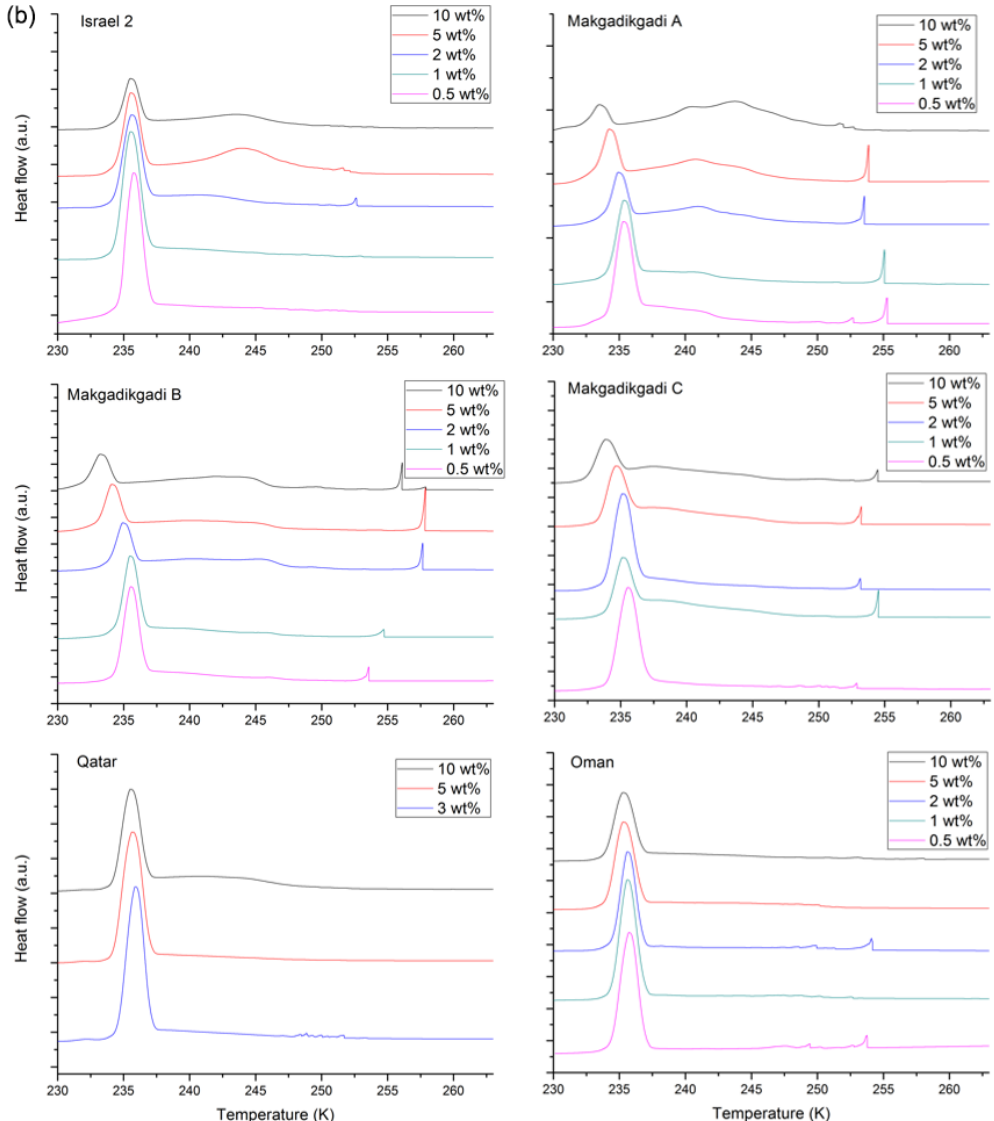
Figure 3. (a) DSC thermograms of natural dust samples: Antarctica, Antarctica (milled), Bolivia, Etosha, Hoggar and Israel 1. (b) DSC thermograms of natural dust samples: Israel 2, Makgadikgadi (A, B, and C), Qatar and Oman. Suspension concentrations are given in the